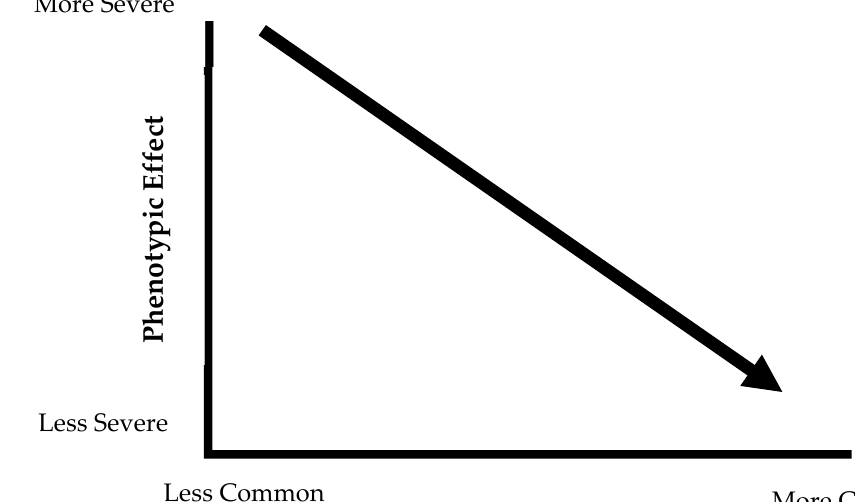
Figure 1. Graphic representation of phenotypic effects of rare versus common variants. Rare variants, such as monogenic disorders, fall on the left of the graph. Common variants with a less severe phenotypic effects are on the right.